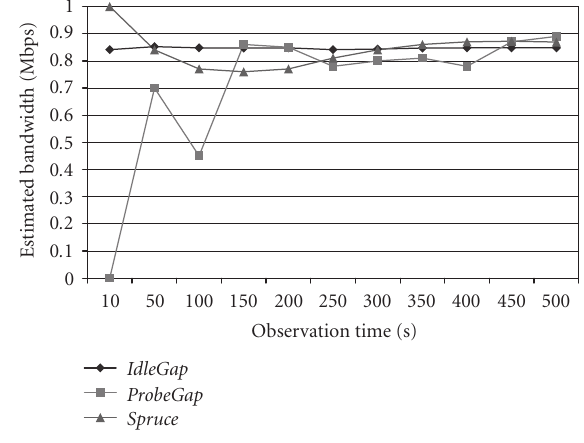
Figure 6: Estimated bandwidth with di ff erent observation